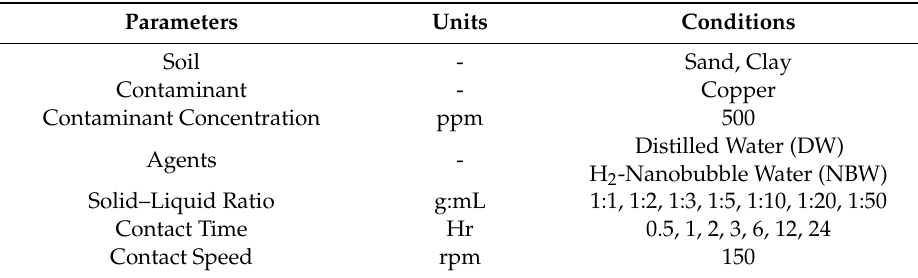
Table 3. Batch-test conditions.